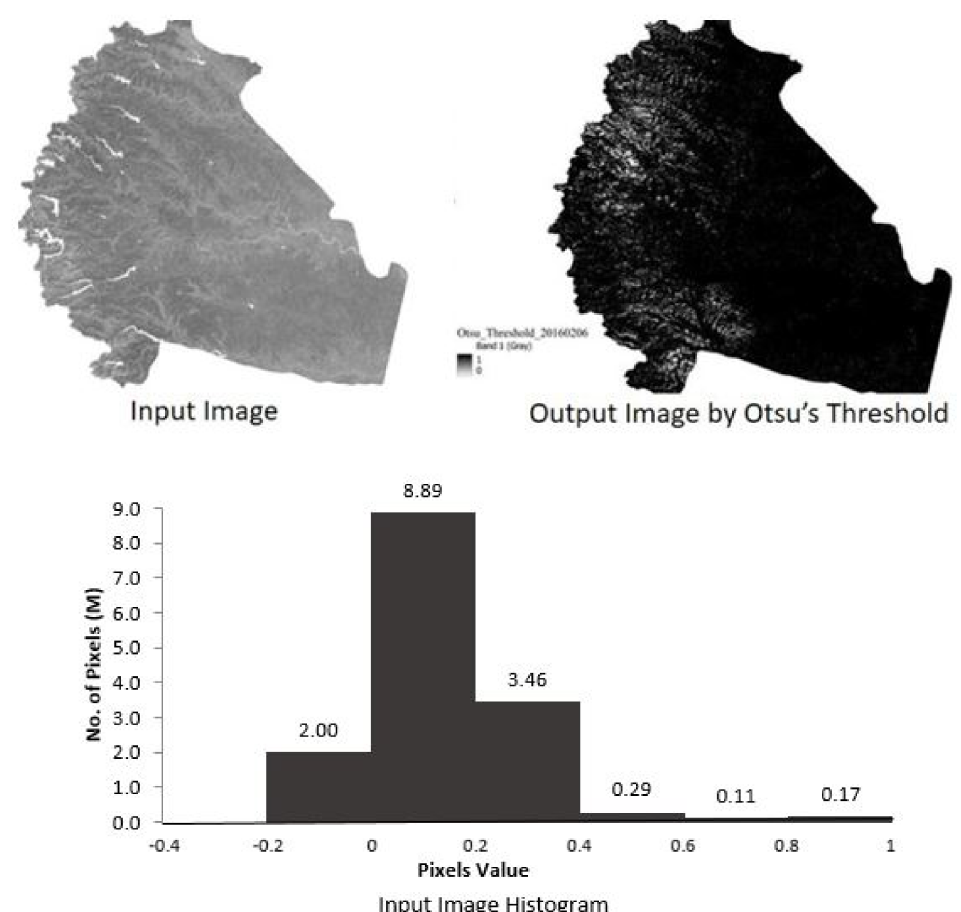
Figure 5. Result of Otsu’s threshold for Modified Normalized Difference Water Index (MNDWI) image on 6th February 2016. Landsat 8 image courtesy of the U.S. Geological